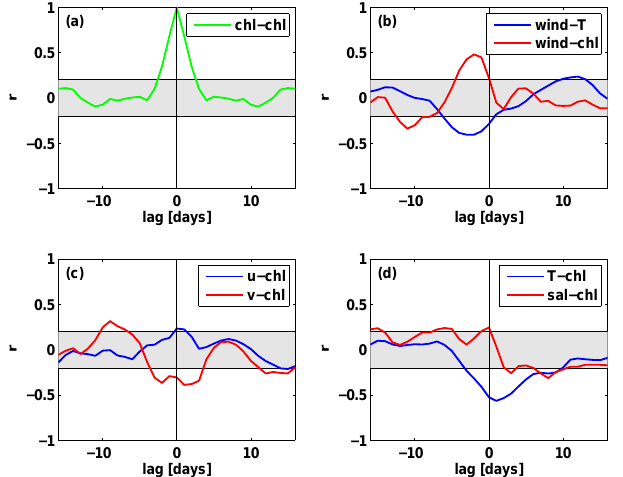
Figure 5. Hovmuller plots of remotely sensed observations along the equator centered at the mooring location: (a) microwave opti- mally interpolated SST; (b) SSH anomaly from AVISO; (c) wind speed from WindSat and (d) satellite chlorophyll from MODIS and SeaWiFS combined. Panel (e) is the fluorometer time series from the mooring, at 25m depth. Black contours in the Hovmuller plots are 28.5 ◦ C in (a) , 8ms − 1 in (c) and 0.15mgm − 3 in (d) . The num- bers in (e) indicate six major chlorophyll peaks observed at the